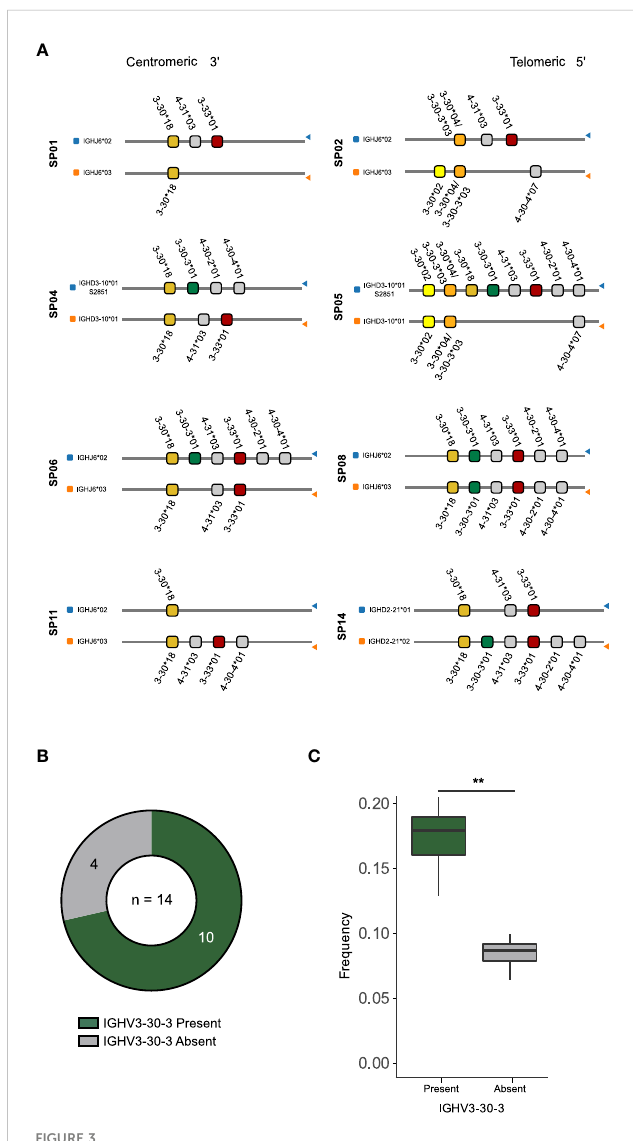
FIGURE 3 Haplotype and genotype analysis reveals variation and IGHV3-30-3 deletion (A) Illustration of IGHV3-30, IGHV3-30-3, IGHV3-33 alleles presence on each chromosome of the haplotypable study participants. (B) A pie chart showing frequencies of individuals with the IGHV3-30-3 gene present (green) or absent (gray). (C) Combined IGHV3-30/IGHV3- 30-3 frequencies in IgM libraries of individuals with the IGHV3-30-3 present (green) or absent (gray). ** refers to the signi fi cant difference between the groups indicated by p value ≤